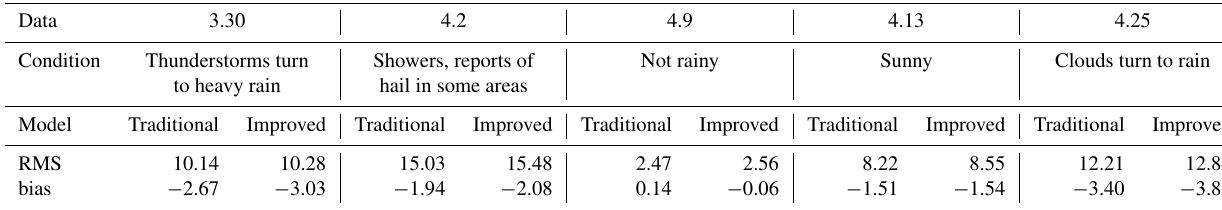
Table 7. Statistics of two models’ accuracy of SWVs for different weather conditions for 5 days (unit: mm). Data Condition Thunderstorms turn Showers, reports of Not rainy Sunny Clouds turn to rain to heavy rain hail in some areas Model Improved Improved